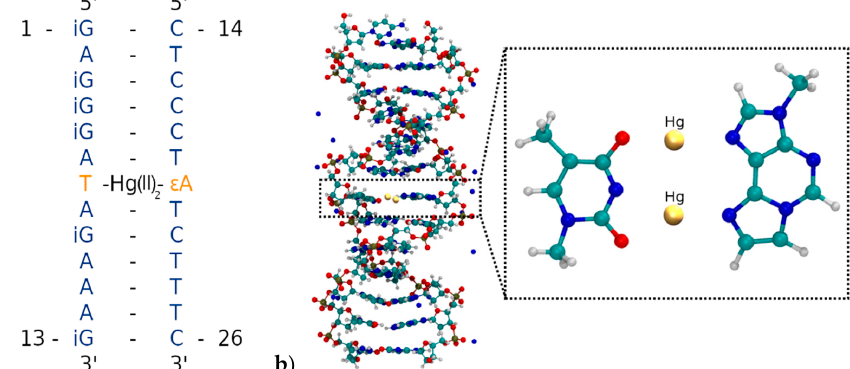
Figure 6. ( a ) Parallel-stranded DNA duplex with numbering of the nucleobases from the 5 ′ to the 3 ′ end. T 7 is deprotonated and forms a dinuclear Hg(II)-mediated base pair with the modified base ε A 20. ( b ) Insertion of the T7–Hg(II) 2 – ε A 20 base pair into the parallel-stranded DNA duplex. Only the DNA and the Na + counter-ions are displayed, while water molecules are not shown.